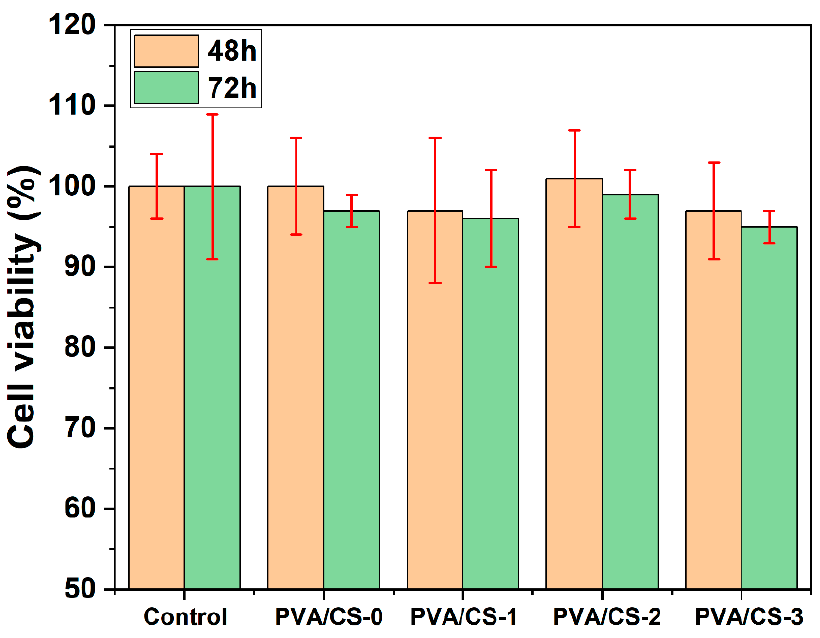
Figure 7. MTT test results for all PVA/CS composites.